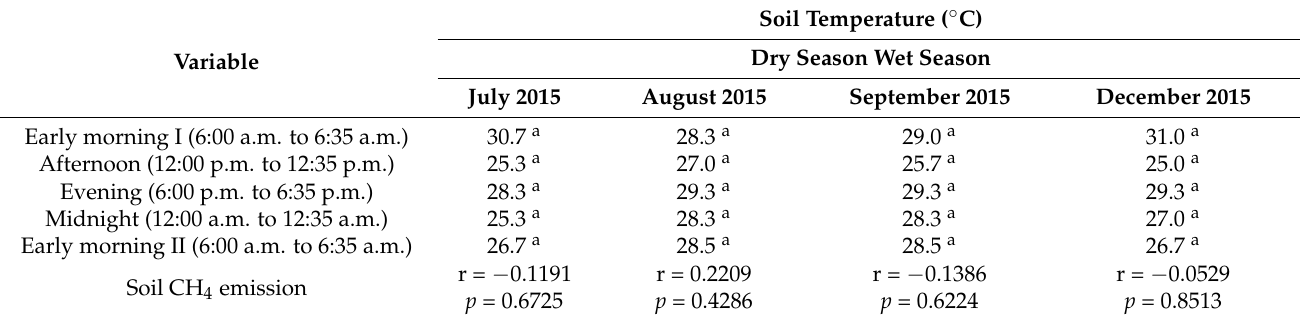
Table 1. Relationship between soil CH 4 emission and soil temperature from a peat soil cultivated with pineapples throughout the dry and wet seasons in